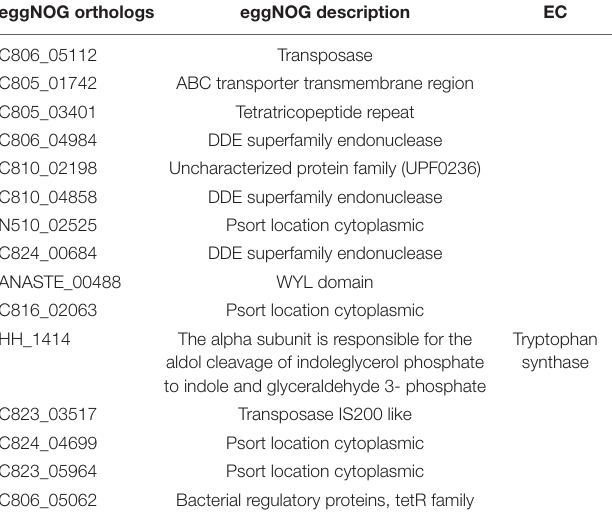
TABLE 2 | Different eggNOG orthologs annotation. eggNOG orthologs eggNOG